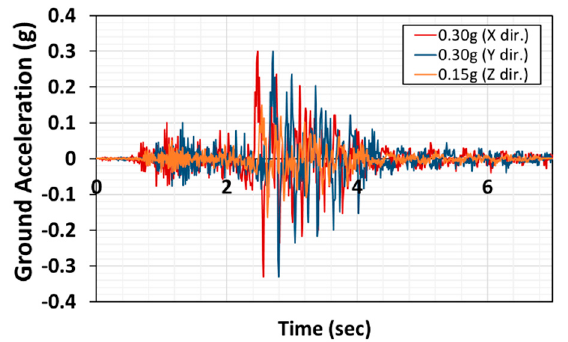
Figure 16. The measured Gyeongju earthquake data (scaled to a maximum of 0.3 g).